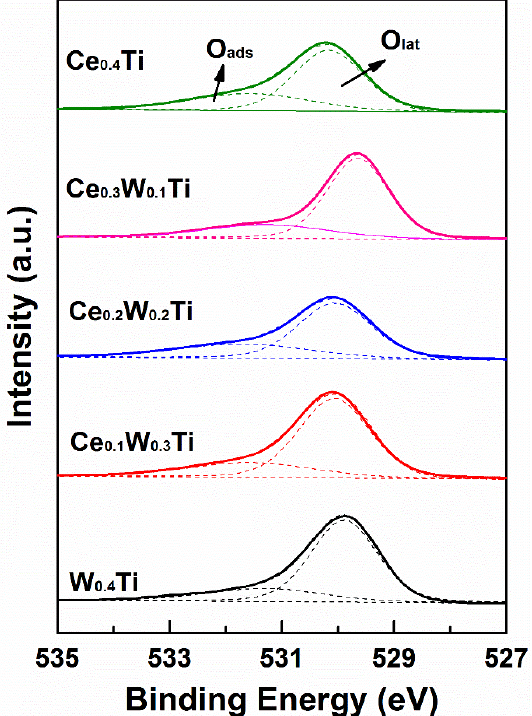
Figure 4. X-ray photoelectron spectrometry (XPS) spectra of O 1s for the Ce-W-Ti catalyst.